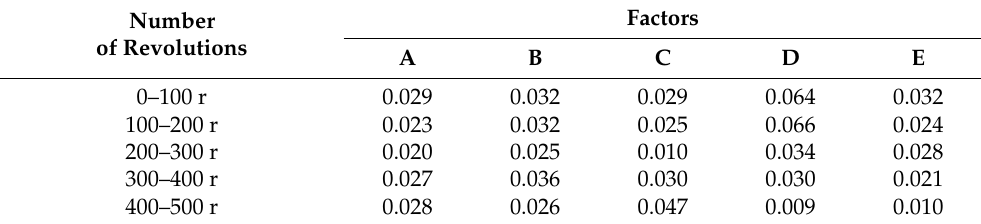
Table 11. Measurement of paint film mass